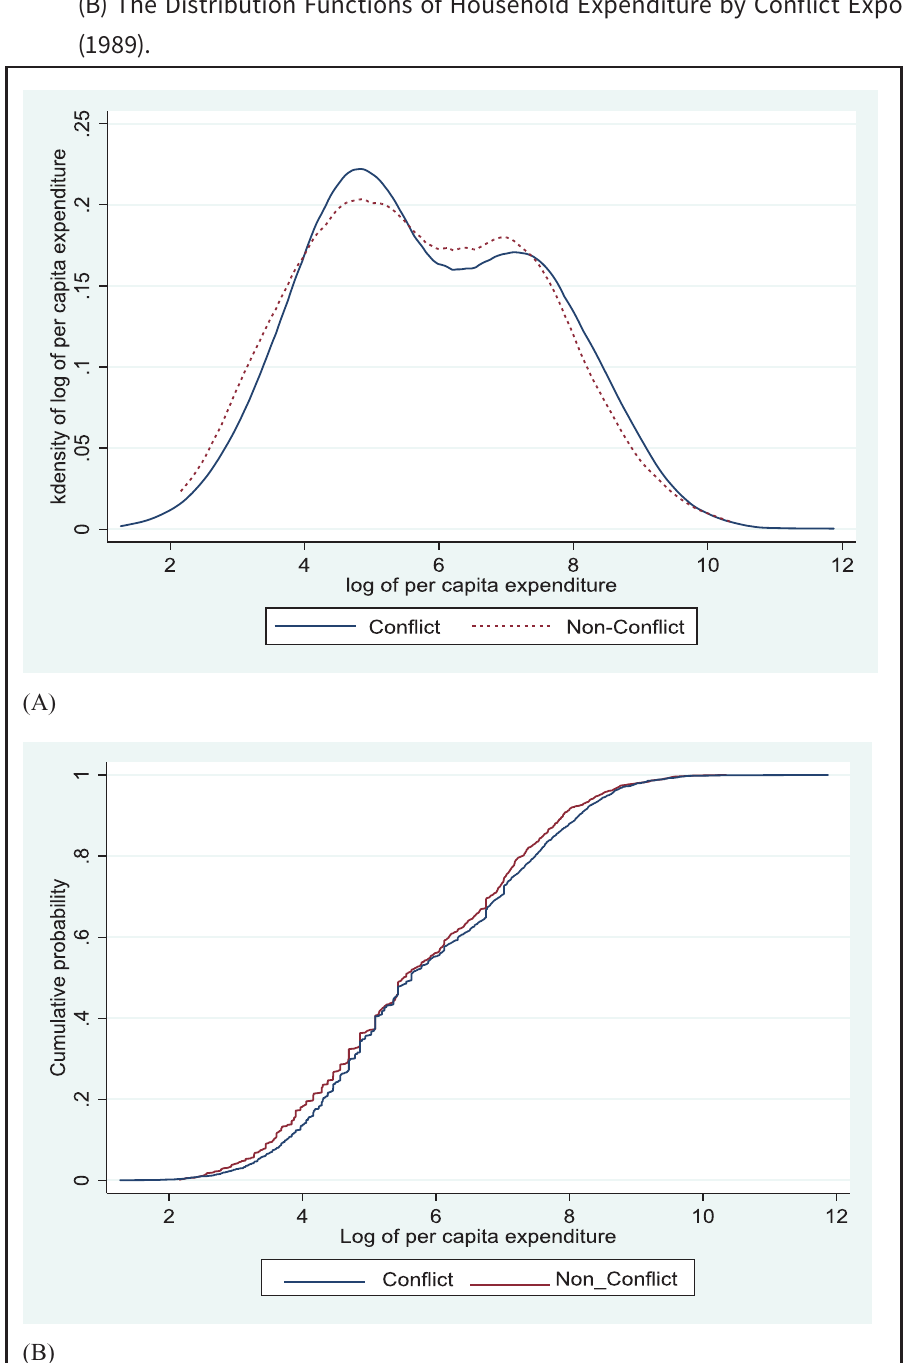
(A) The Density Functions of Household Expenditure by Conflict Exposure (1989). (B) The Distribution Functions of Household Expenditure by Conflict Exposure (1989).